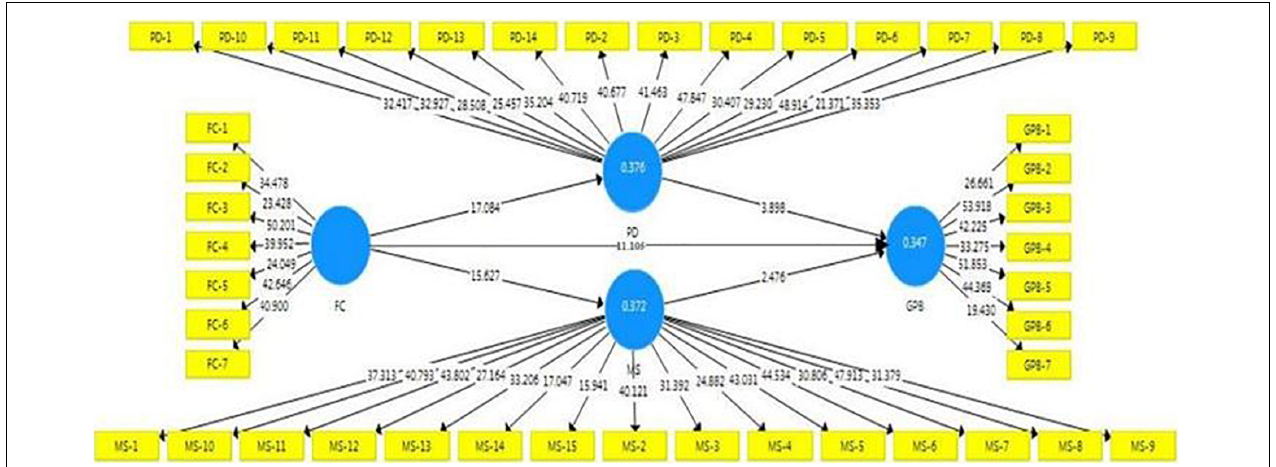
FIGURE 2 | The bootstrapping result.